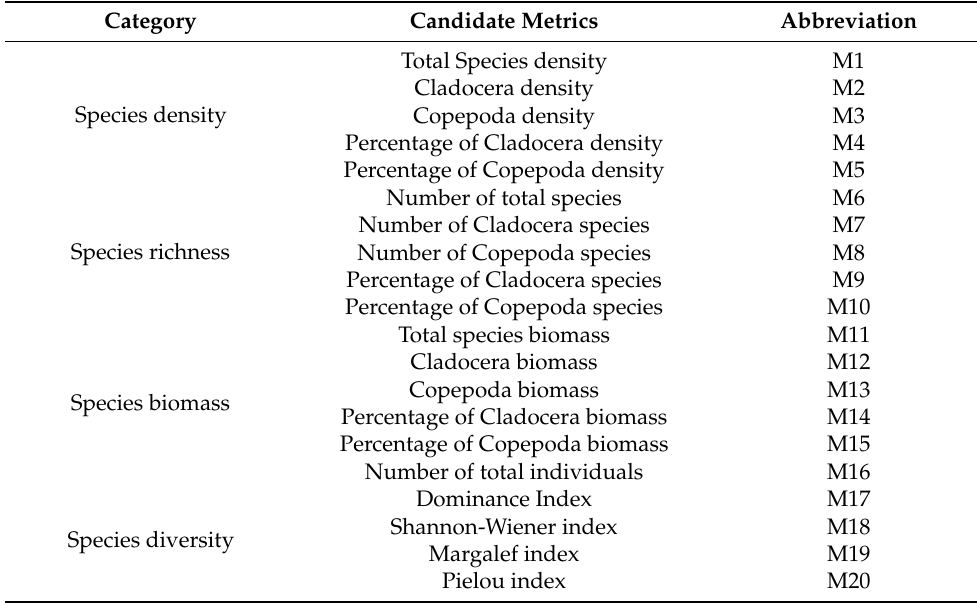
Table 1. Multiple metrics for calculating the Z-IBI scores in the Wanan River basin, China.